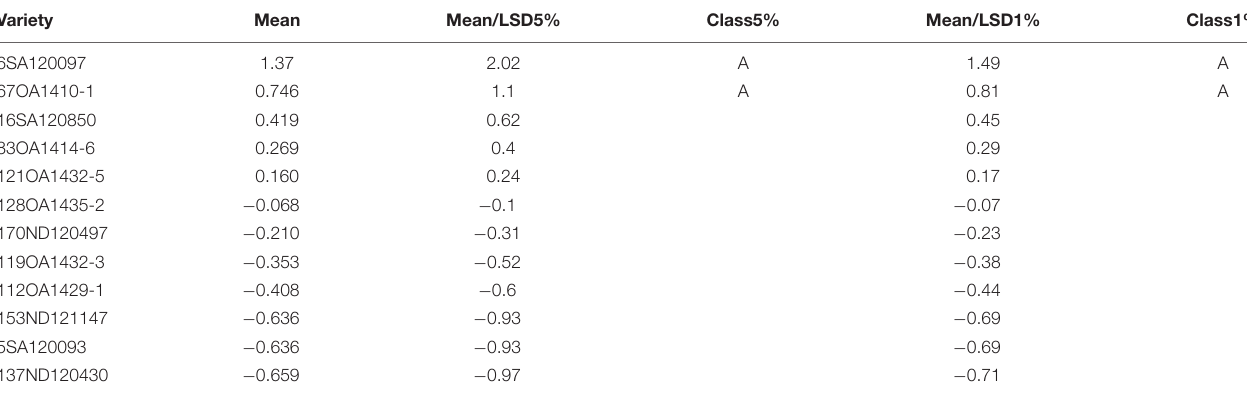
TABLE 9 | Effects of salt, alkali stresses on the panicle number of tolerant and sensitive oat genotypes in experiment 3. Variety Mean